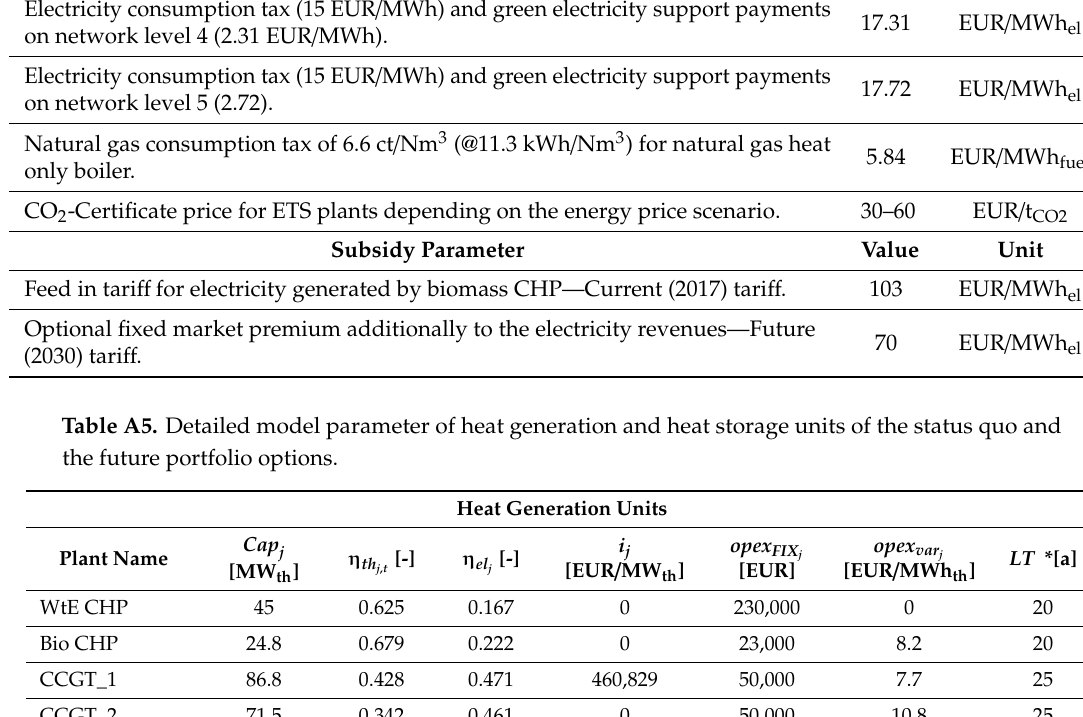
Table A4. Tax and subsidy parameter (Source: e-control: https: // www.e-control.at). Tax Parameter